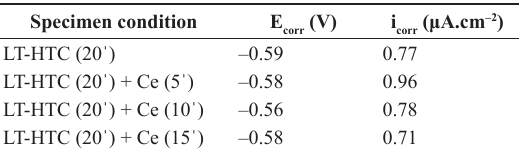
and i in 0.01 M NaCl. corr corr